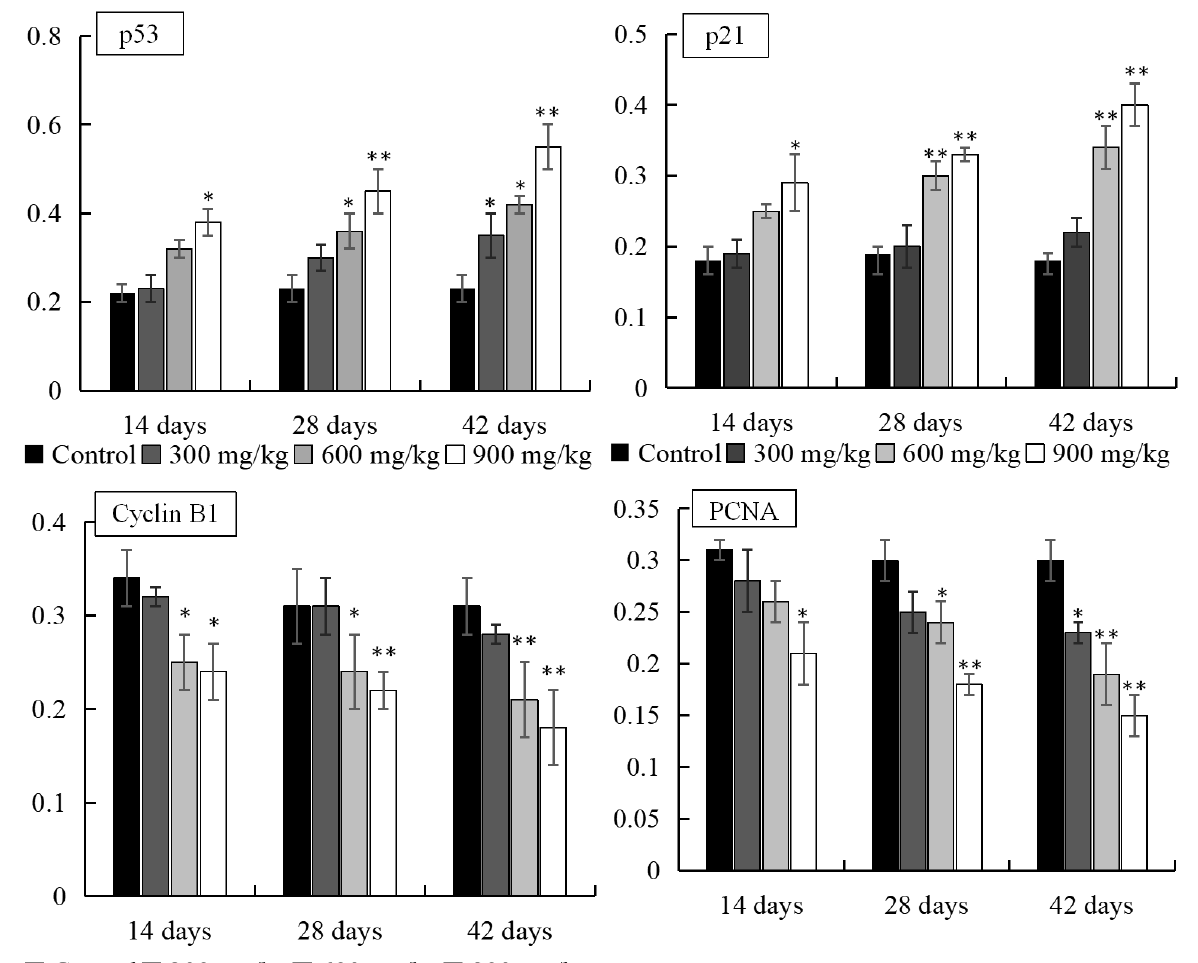
Figure 3. Changes of the mean density of p53, p21, Cyclin B1 and PCNA protein expression in the cecal tonsil. Data are presented with the mean ± standard deviation (n=6×6) *P<0.05, compared with the control group **P<0.01, compared with the control